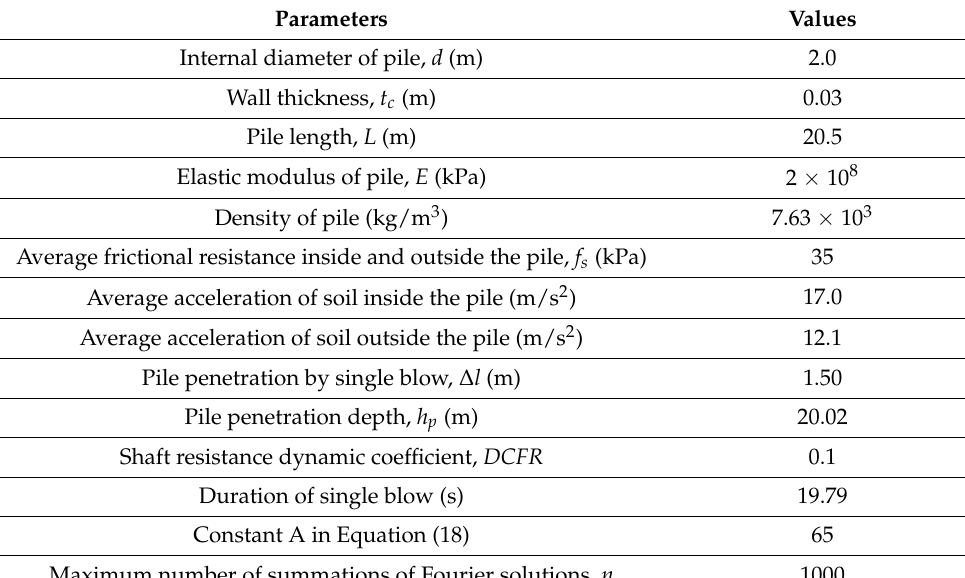
Figure 6. A typical finite element model in this study. Table 2. Adopted parameters values for comparison analysis.